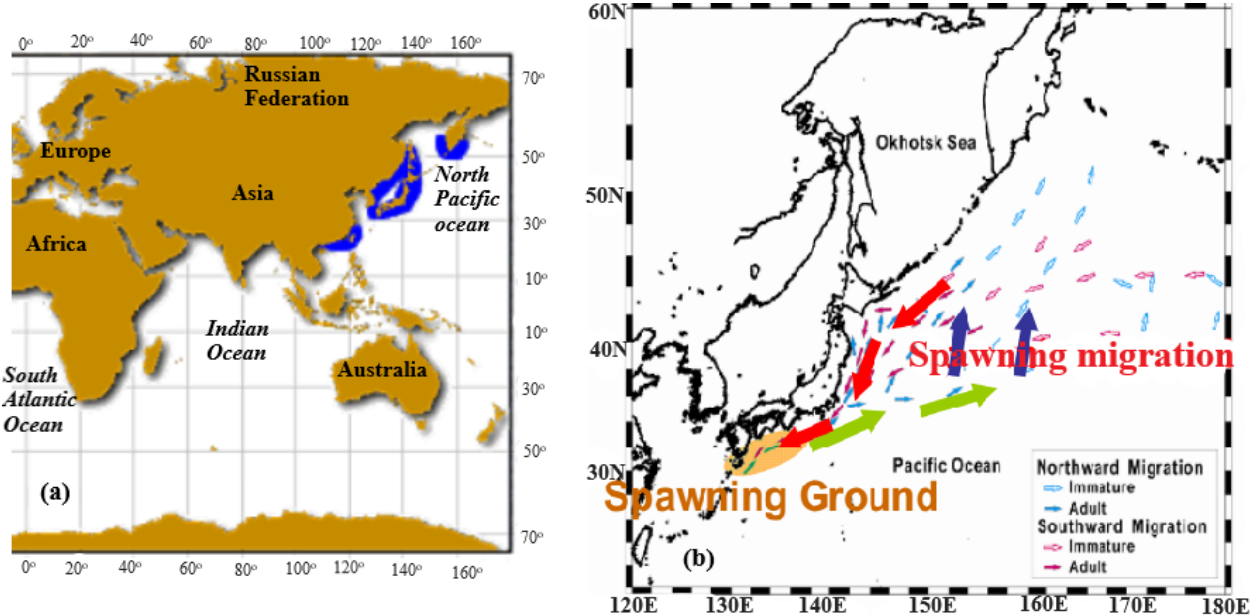
Figure 1. Distribution of Japanese sardine ( Sardinops melanostictus ) in the Pacific Ocean indicated in blue, left image ( a ), and spawning regions and migration patterns by immature (light blue and red arrows) and mature (thick blue and red arrows) Japanese sardines; the light green on the right map shows the spawning grown of this species ( b ). Images are from [8,50].